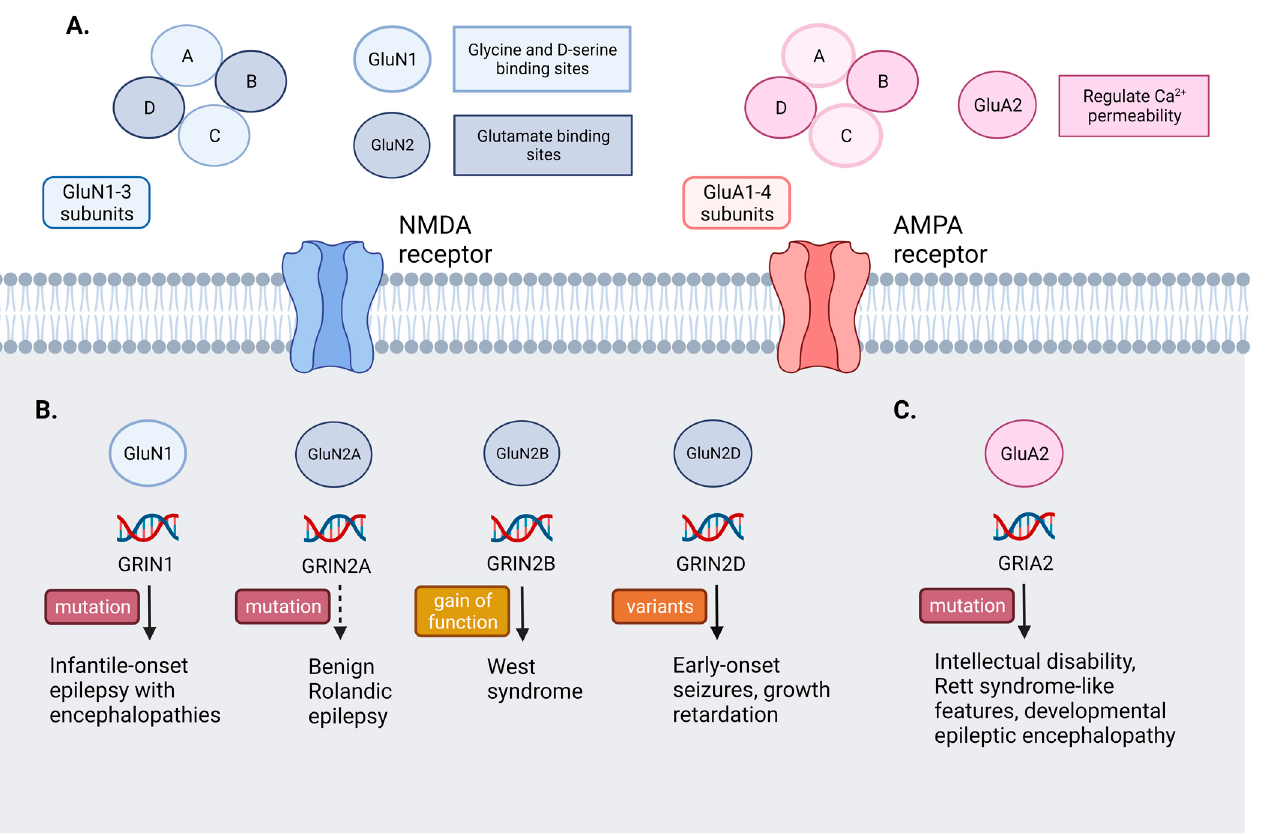
Figure 2. Structures and possible mutations of ionotropic glutamate receptors with associated clinical features. ( A ) Ionotropic glutamate receptors such as NMDA and AMPA receptors share a common tetramer containing A–D subunits in different combinations of subunits. In NMDA receptors, the GluN1 subunit is essential for all functional NMDARs and has binding sites for glycine and D-serine. The GluN2 subunits provide glutamate-binding sites and control the expression and functional properties of NMDARs. In AMPA receptors, the GluA2 subunit is the key site for regulating calcium permeability. ( B ) Mutations in the subunits have been found to cause clinical syndromes. GRIN1 missense mutations can cause infantile-onset epilepsy with encephalopathies. GluN2A mutations are related to benign Rolandic epilepsy. GRIN2B gain-of-function mutation causes West syndrome. Some GRIN2D variants were reported with initial early-onset seizures. ( C ) The heterozygous mutations of GRIA2 gene encoding GluA2 subunit were found to have phenotypes of intellectual disability, neurodevelopmental abnormalities, and seizure (Figure created with BioRender.com, accessed on 23 February